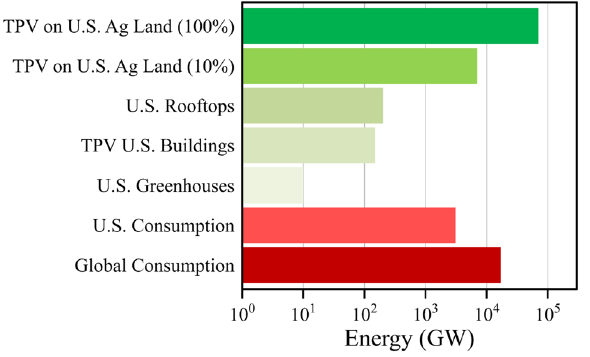
Figure 6. Potential energy output of agrivoltaics. The potential energy output of agrivoltaics on US agricultural land significantly surpasses the energy generation of rooftop solar and other integrated solar approaches. Agrivoltaics with 10%-efficient panels would produce more than double the US energy consumption with only 10% coverage of US agricultural land, and more than quadruple the global energy consumption with 100% coverage of US agricultural